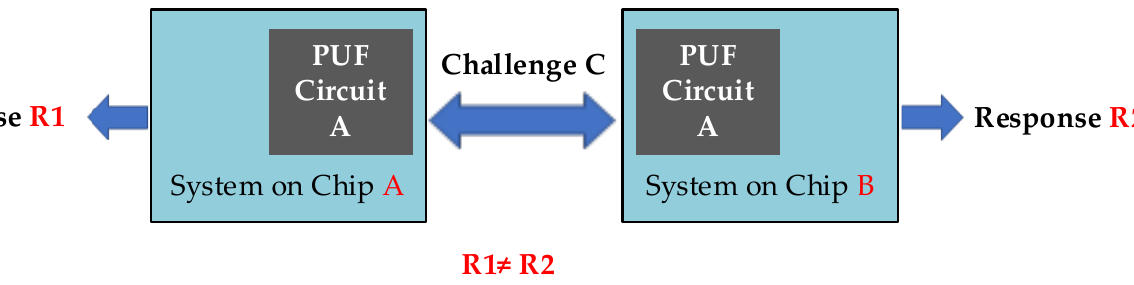
Figure 1. Two identical PUF circuits on two different chips generate different responses (modified from [15]).